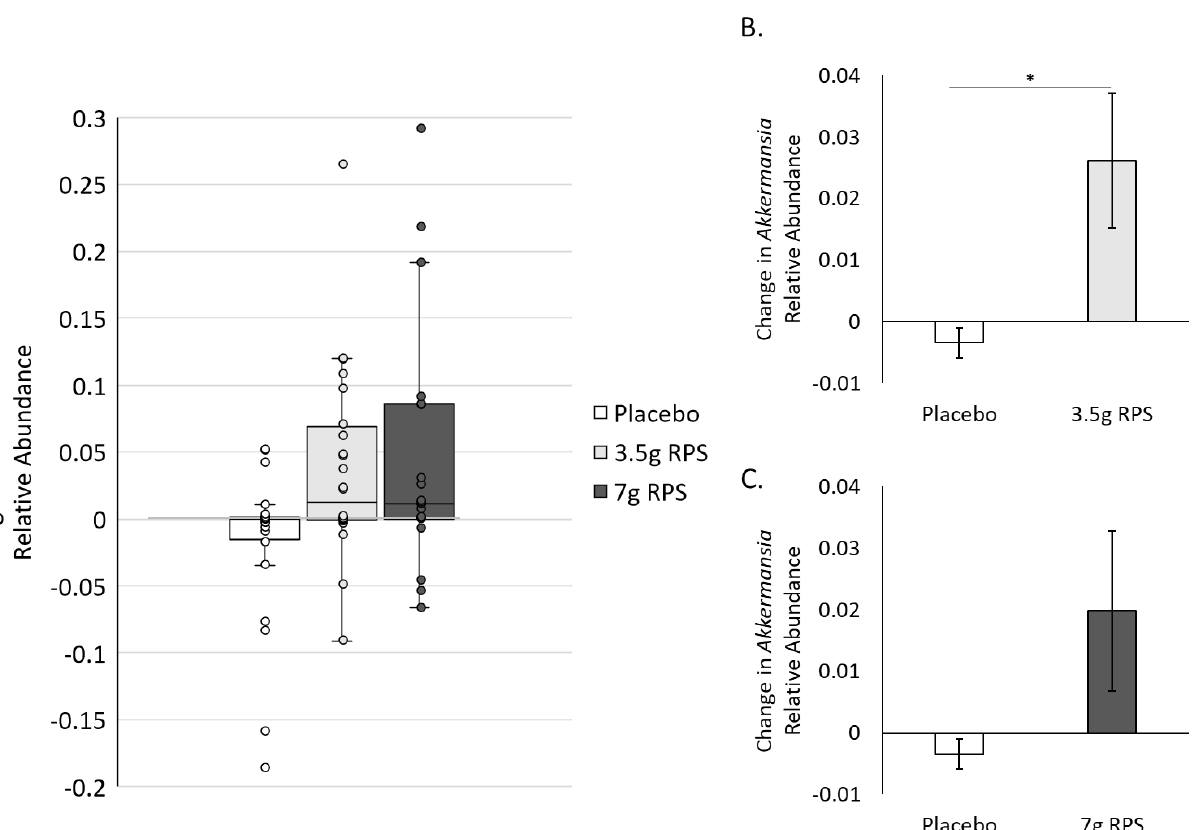
Figure 3. Increases in the relative abundance of Akkermansia after 4 weeks in response to placebo, 3.5 g RPS, or 7 g RPS. ( A ) Box and whisker plots revealing interquartile range (IQR; box), median (line inside box), and 1.5 times the IQR (error bars), as well as individual data points (circles). ( B ) The increase in the relative abundance of Akkermansia was significantly higher in the 3.5 g RPS group compared to the placebo arm ( p = 0.014). ( C ) The increase in the relative abundance of Akkermansia was not significantly higher in the 7 g RPS group ( p = 0.056) compared to the placebo arm (Student’s t -test, * p < 0.05).